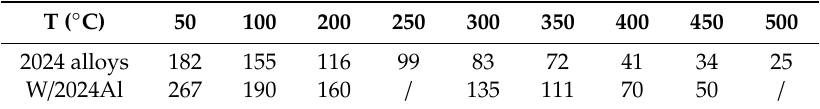
Figure 18. Maximum stresses of as-quenched 2024Al and W/2024Al blocks with the thickness of 36 mm.